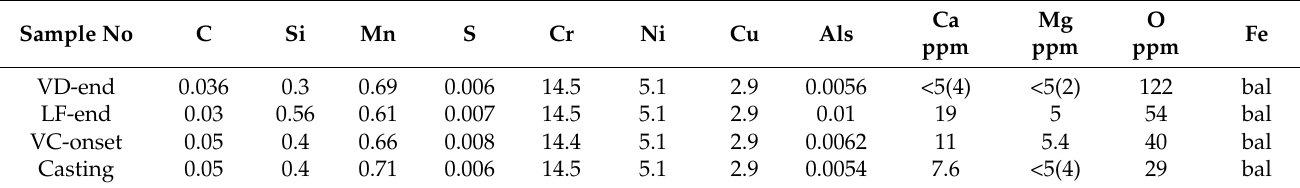
Table 1. Chemical composition of the steel samples (mass